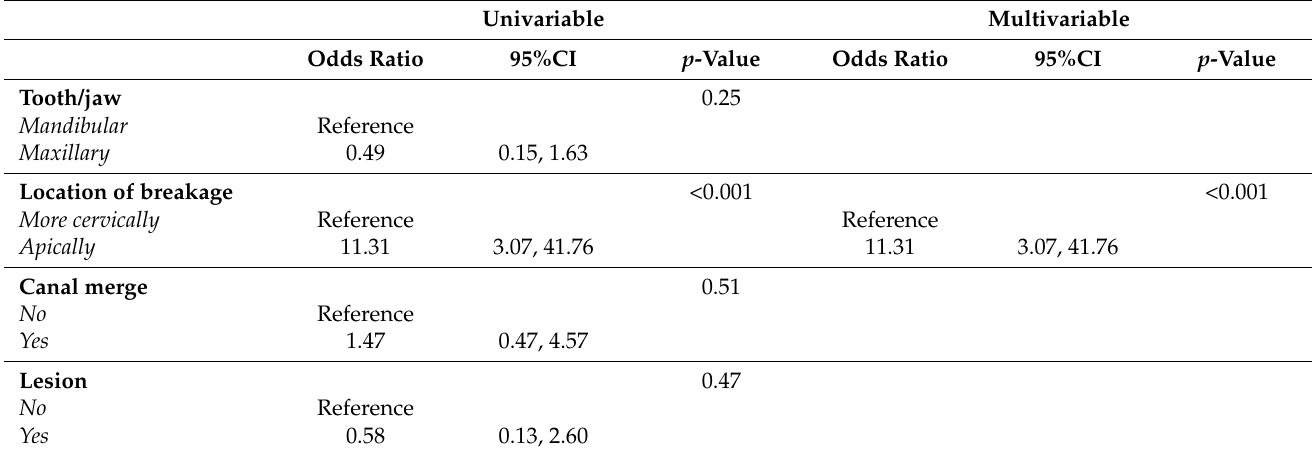
Table 3. Univariable and (plan for) multivariable logistic regression for the effect of tooth and jaw, location of breakage within the root canal (converted to binary: more cervically to apically), canal merge and presence of lesion or otherwise, on alteration of treatment plan from initial conventional periapical radiographic evaluation to final CBCT assessment.